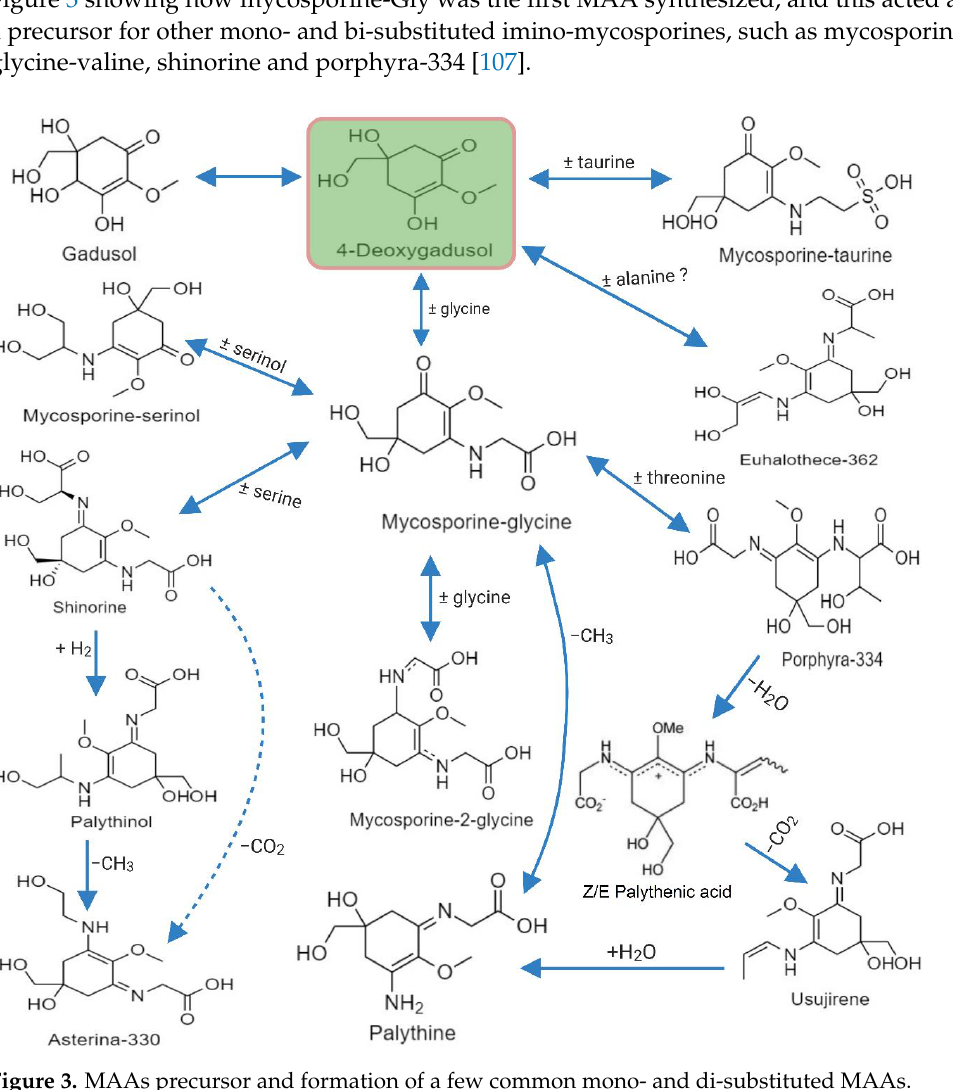
Figure 3. MAAs precursor and formation of a few common mono- and di-substituted MAAs.